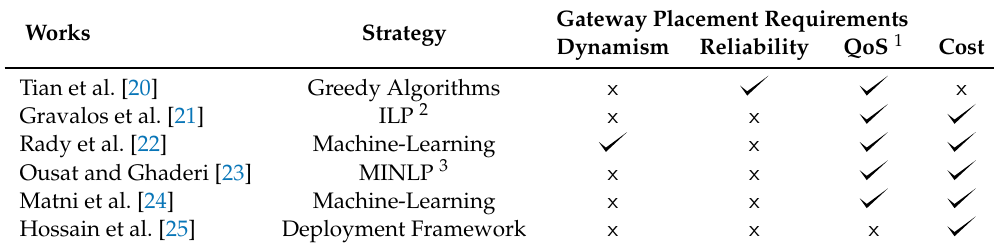
Table 1. Related works